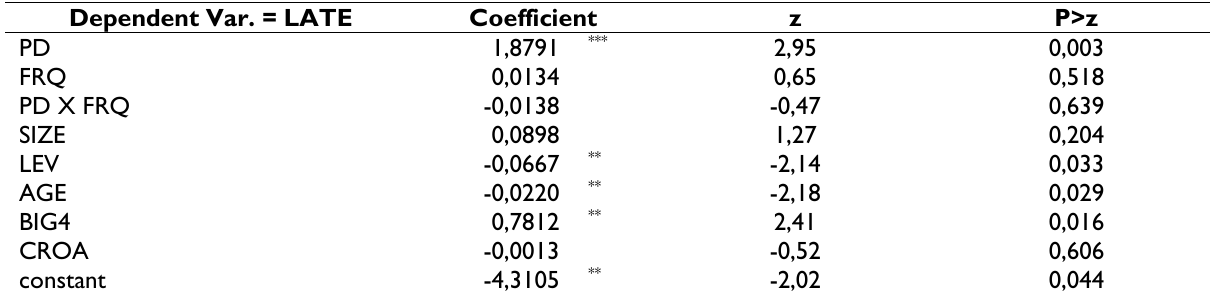
Table 5. The Effect of Financial Distress and Financial Reporting Quality on Financial Reporting Delay Dependent Var. =